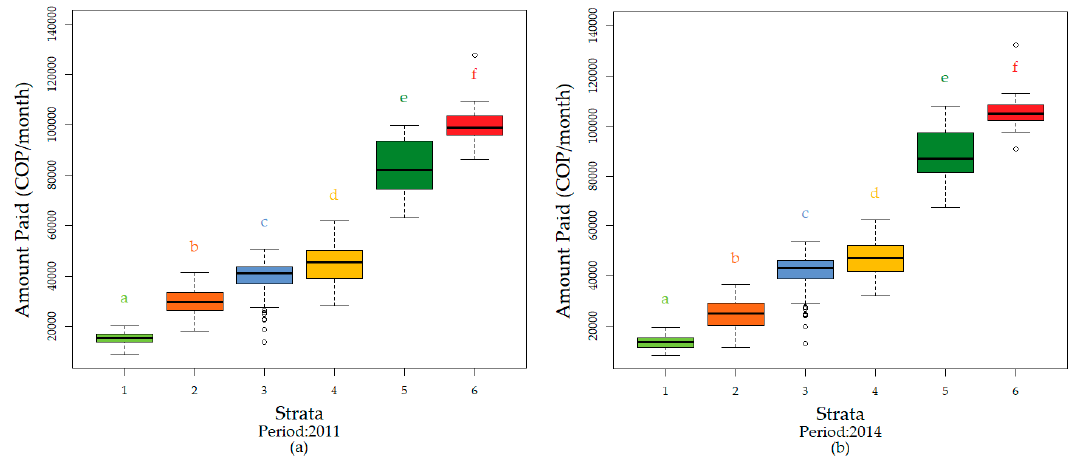
Figure 3. Result of comparison test on amounts paid between strata ( a ) Period 2011; ( b ) Period 2014. Note: Different significances are presented with different letters ( p < 0.1) between strata per year, in the following way: a = a, ab = a, ab = b, a < > b.